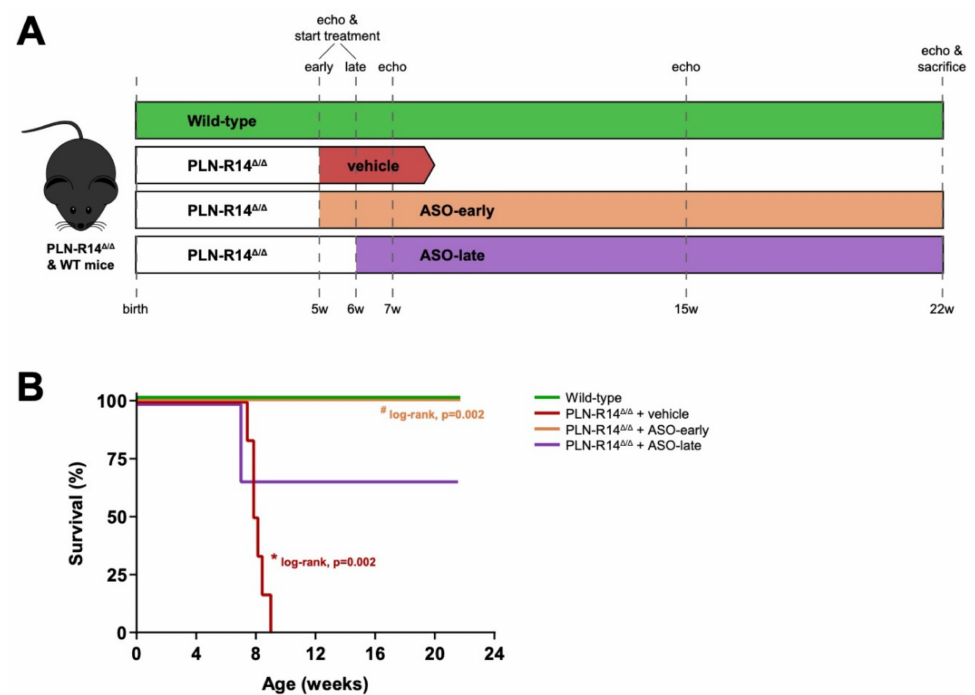
Figure 1. Schematic overview of the study design and survival curve. ( A ) PLN-R14 ∆ / ∆ mice were randomized to administration of PLN-ASO or vehicle (saline). PLN-ASO treatment was initiated at 5 or 6 weeks of age (ASO-early and ASO-late, respectively), when PLN-R14 ∆ / ∆ mice had developed moderate or severe heart failure, respectively. Heart function was determined using echocardiography at treatment start and at the age of 7, 15 and 22 weeks. Survival of PLN-R14 ∆ / ∆ mice was monitored up to 22 weeks of age, when all mice were sacrificed for histological and molecular tissue analyses. ( B ) Percentage survival of WT mice and PLN-R14 ∆ / ∆ mice receiving early or late PLN-ASO treatment or vehicle injections to a maximum of 22 weeks of age ( n = 6 per group). * p < 0.05 vs. WT, # p < 0.05 vs. PLN-R14 ∆ / ∆ + vehicle (log-rank